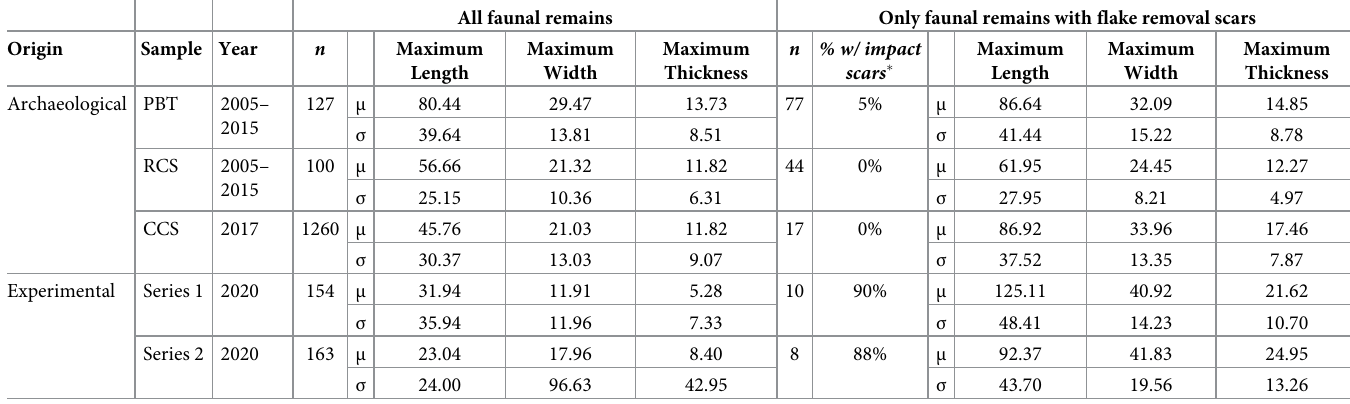
Table 2. Summary of the morphometric data for the samples considered in the present study and comparison with specimens bearing flake scars by sample. All faunal remains Only faunal remains with flake removal scars